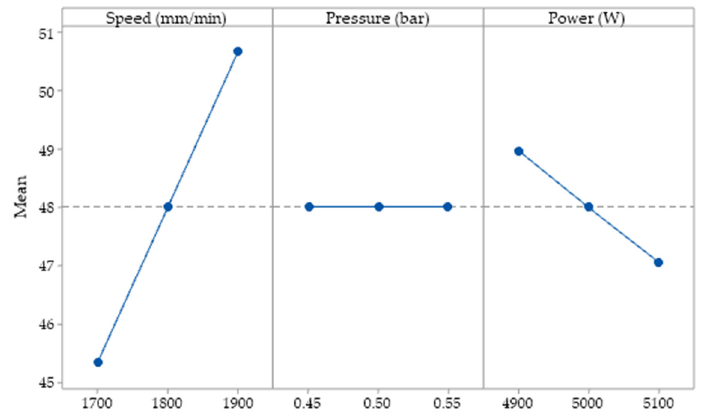
Figure 5. Main effects for cutting efficiency.